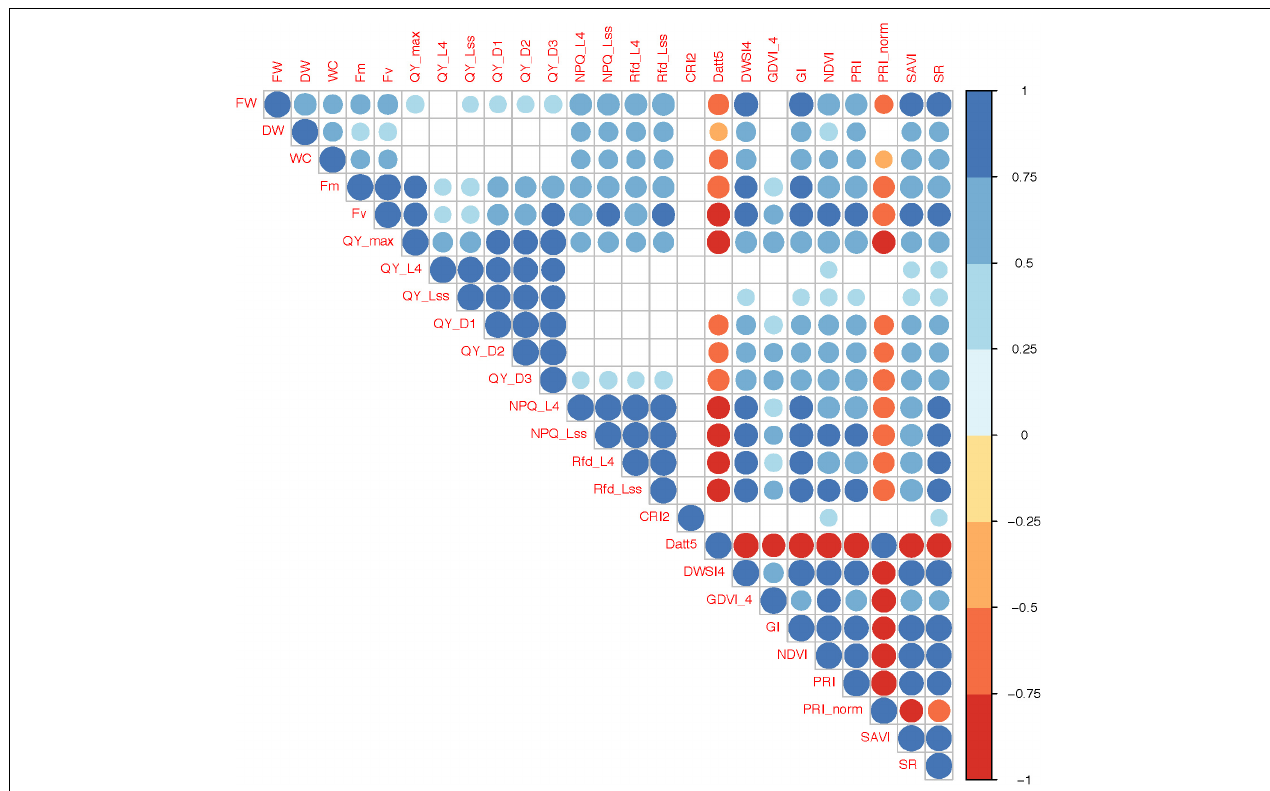
FIGURE 2 | Correlations between horticultural traits, chlorophyll fluorescence parameters and vegetation indices. Only significant correlations ( P -value < 0.05) are presented. The color and size of circles represents direction (positive or negative) and level of significance